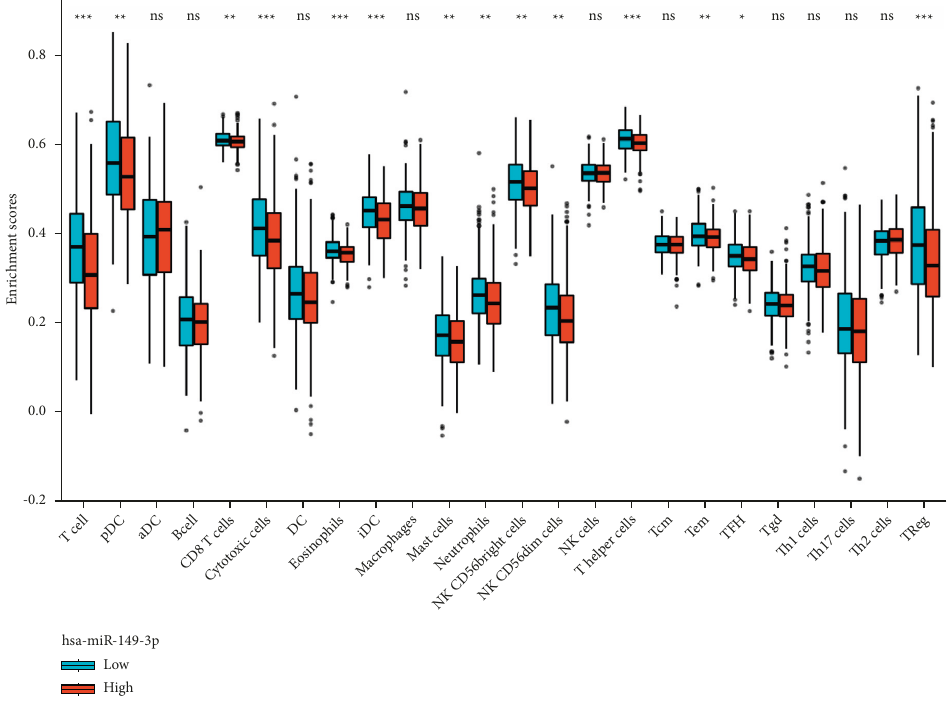
Figure 10: Correlation between miR-149-3p expression and 24 immune cells in UCEC (lollipop chart). The size of the dots indicates the absolute value of spearman r